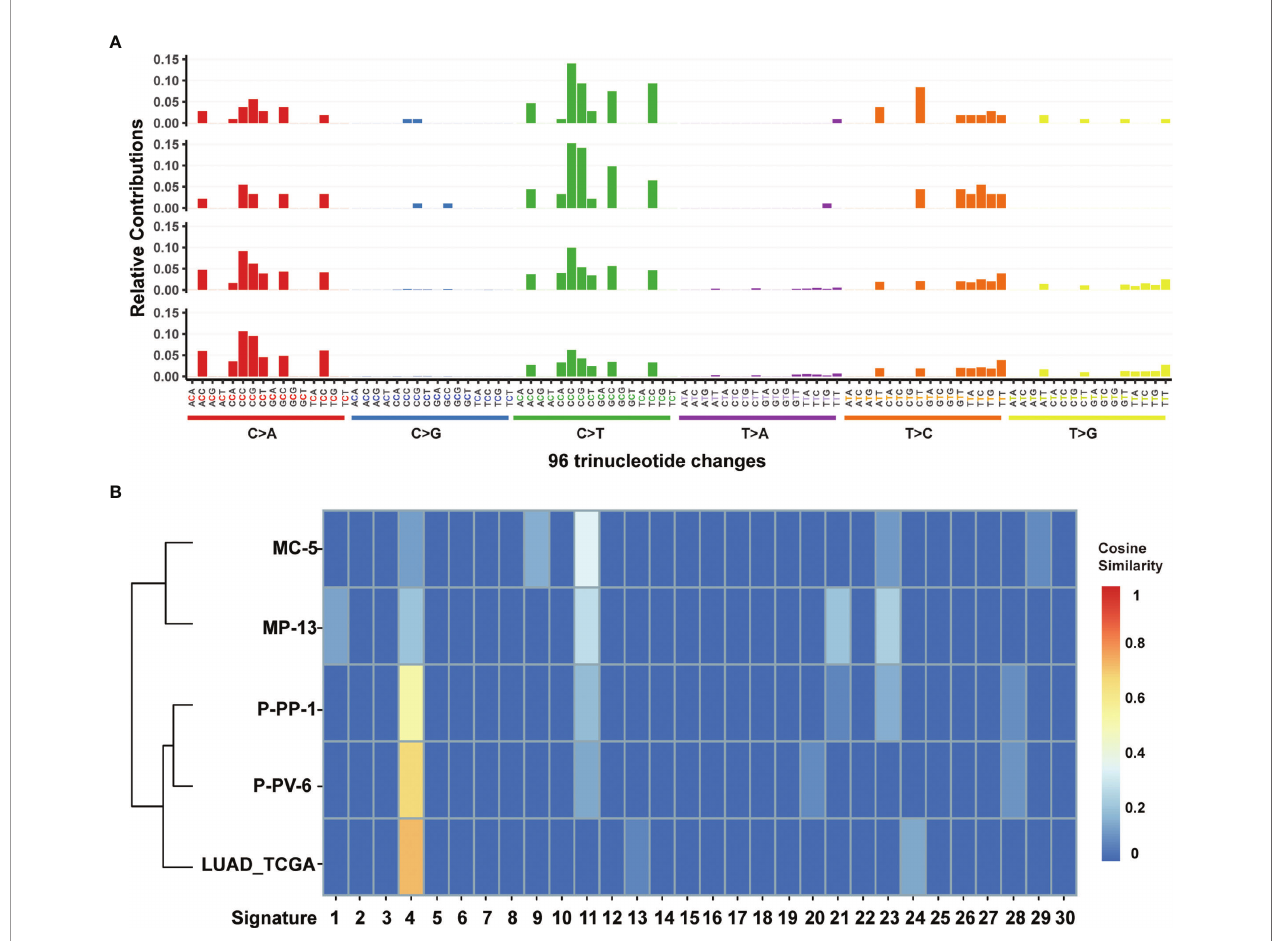
FIGURE 4 | Mutational signature analysis of MC-5, MP-13, P-PP-1, and P-PV-6. (A) Mutational signature pattern of substitutions in MC-5, MP-13, P-PP-1, and P- PV-6 (the order of top-down) based on trinucleotide frequency. (B) Cosine similarity heatmap between the mutational pro fi les of MC-5, MP-13, P-PP-1, P-PV-6, and lung adenocarcinoma (LUAD) with high